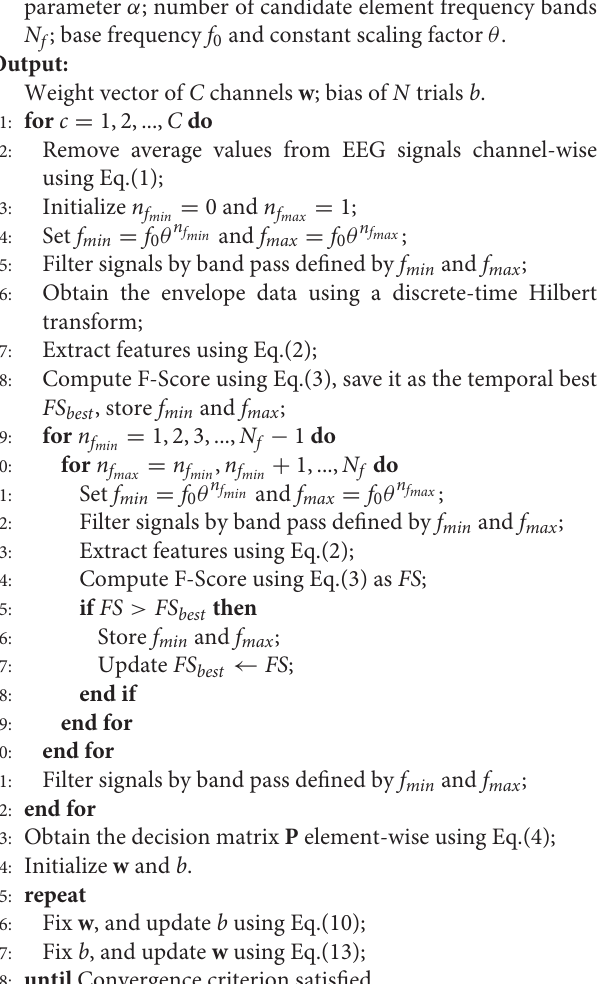
+ TNC 2 ), where T is the number of f